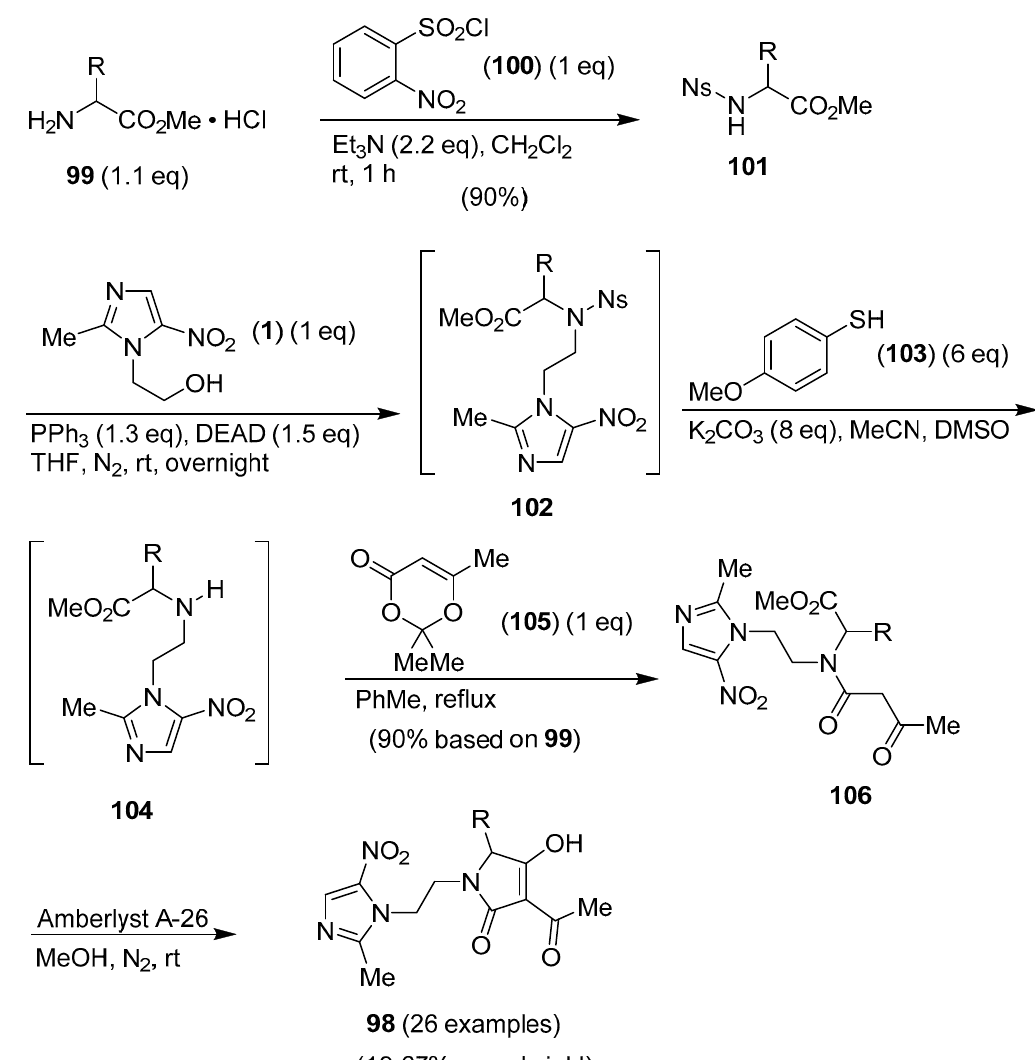
Scheme 19. Synthesis of N -substituted metronidazole / tetramic acid hybrids